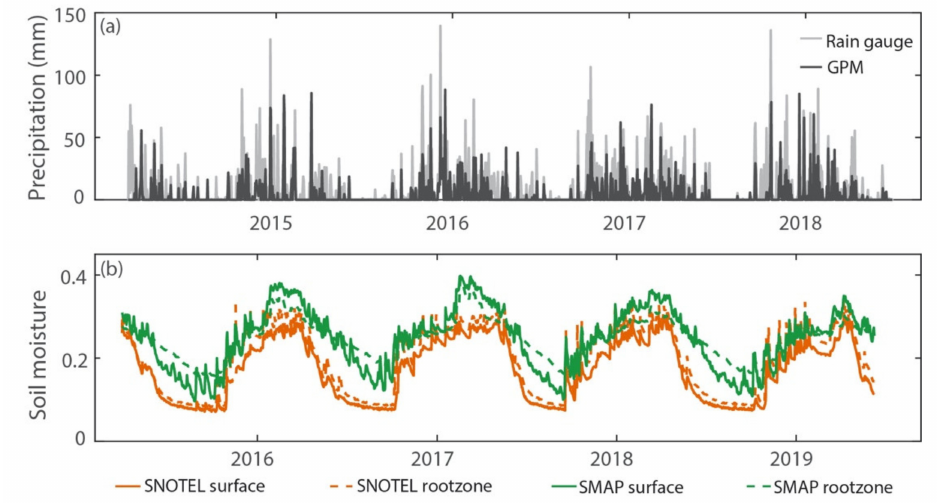
Figure 4. ( a ) Comparison between daily satellite-based (i.e., GPM) and in situ (at station Three Corner Rock: https://wrcc.dri.edu/cgi-bin/rawMAIN.pl?waWTCR accessed on 21 April 2021) measurements of precipitation over the Cascades Landslide Complex. ( b ) Comparison between satellite-based (SMAP) and in situ (at station Log Creek) measurements of soil moisture over the Cascades Landslide Complex. GPM measurements have been provided since 13 March 2014 and SMAP soil moisture from 31 March 2015. In situ measurements of precipitation and soil moisture were made at a specific location, but both satellite measurements were calculated within a coarse resolution of 0.1 ◦ (GPM) and 9 km